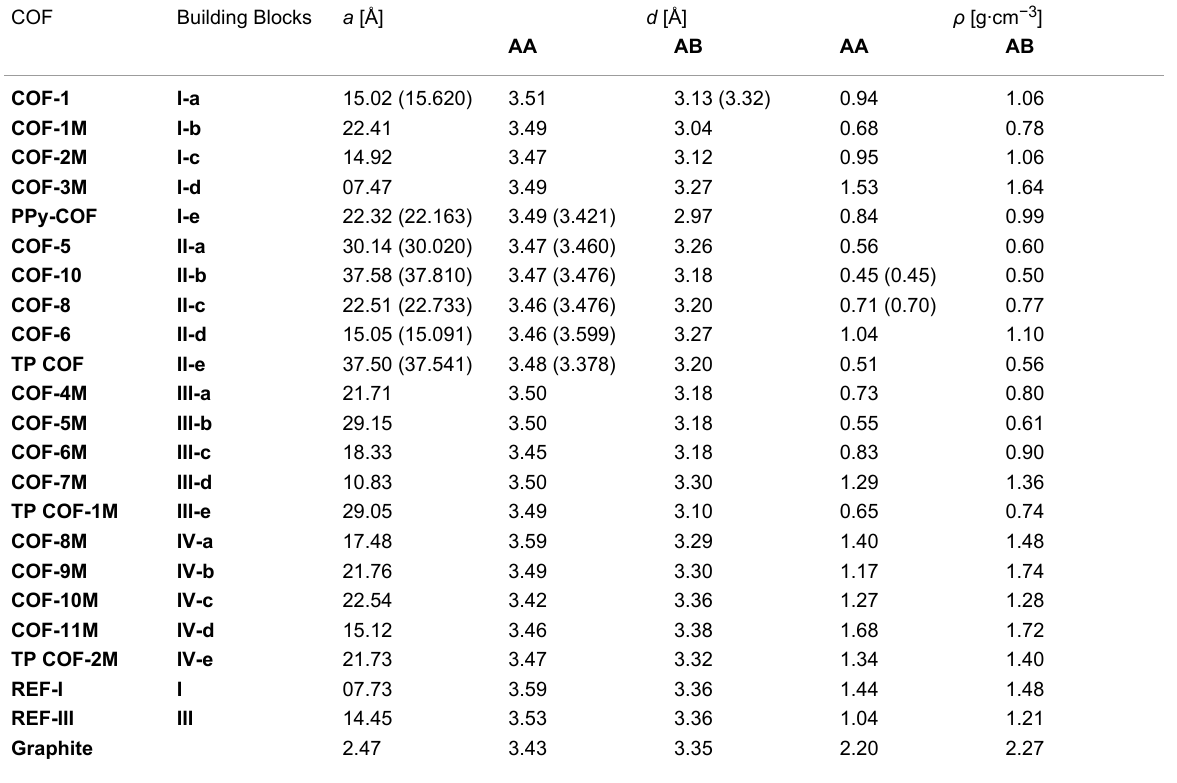
Table 1: The calculated unit cell parameter a [Å], interlayer distance d [Å] and mass density ρ [g·cm − 3 ] for AA and AB stacked COFs. Note that the cell parameter a is the same for all stacking types. Experimental data [7,19] is given in parentheses. COF Building